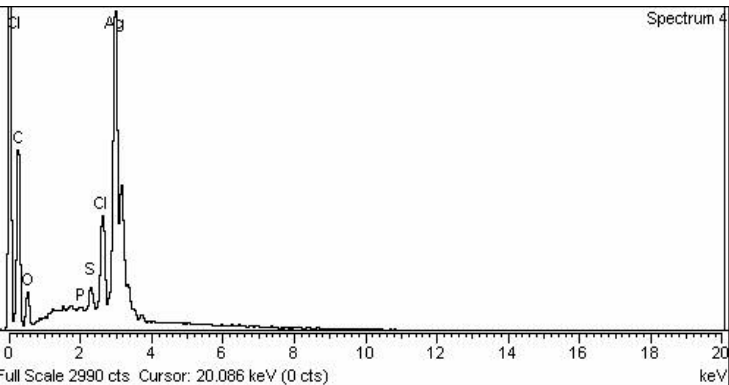
Figure 4. EDX of AgNPs.